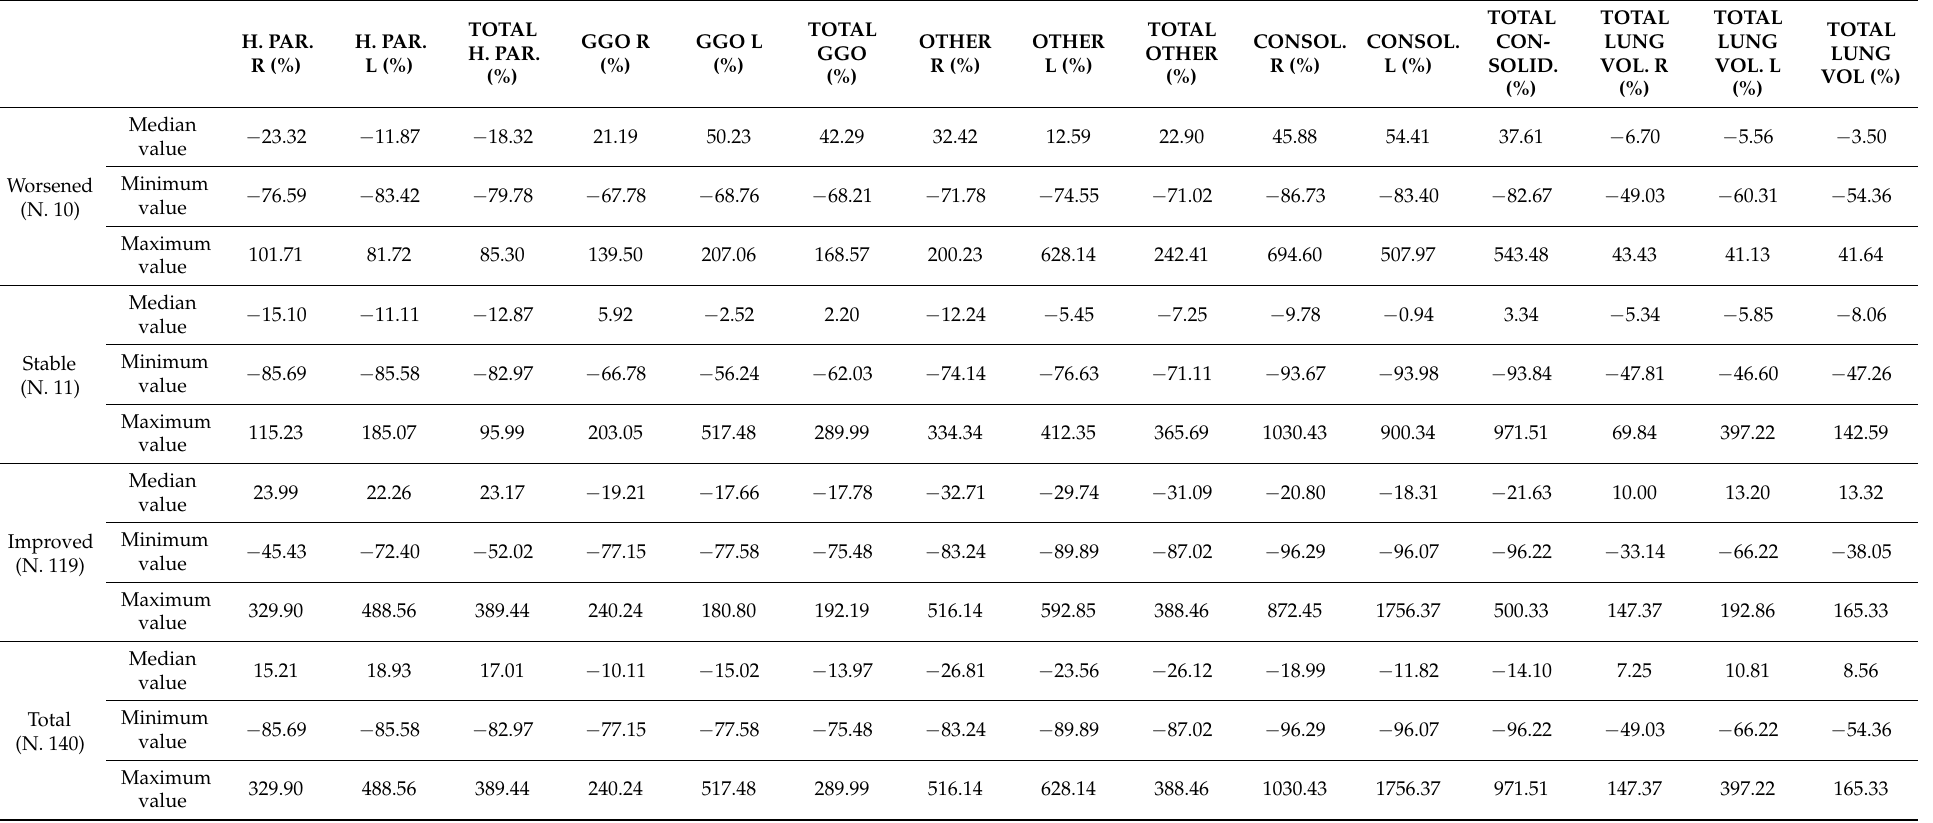
Table 1. Percentage change of quantified volume between baseline CT and follow-up